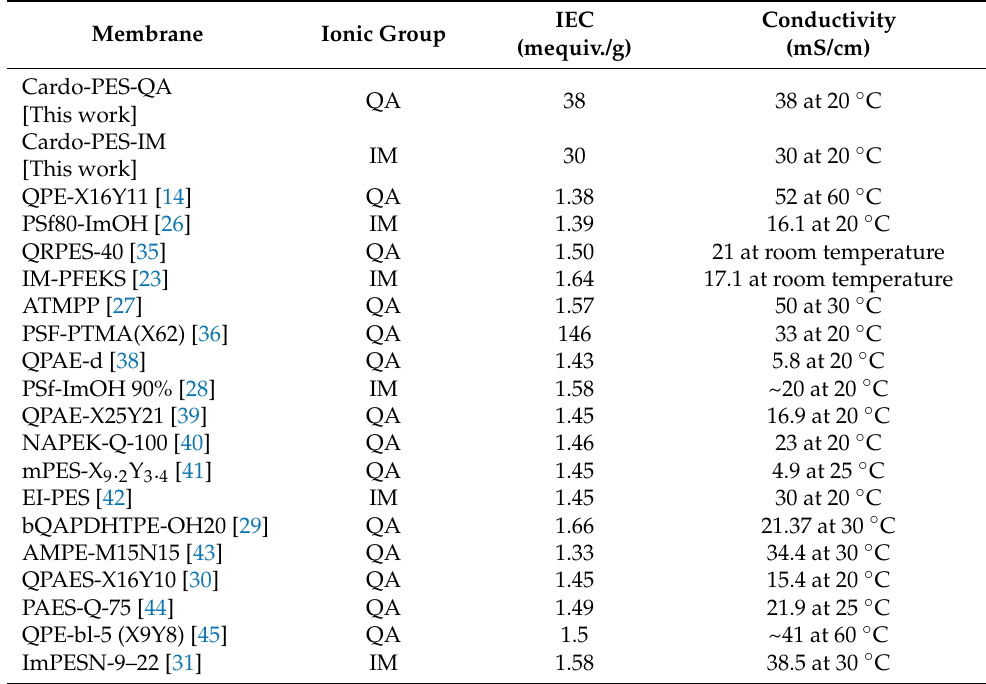
Table 4. IEC and hydroxide conductivity of different